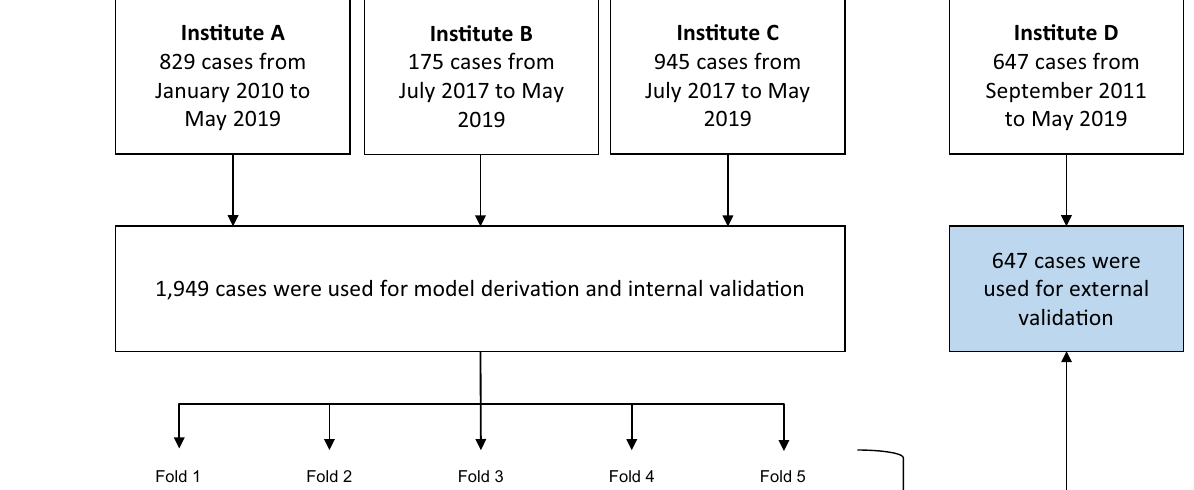
Figure 1. Flow chart of the study population and the internal and external validation process. Institute A: Seoul Saint Mary’s Hospital. Institute B: Seoul National University Hospital. Institute C: Chonnam National